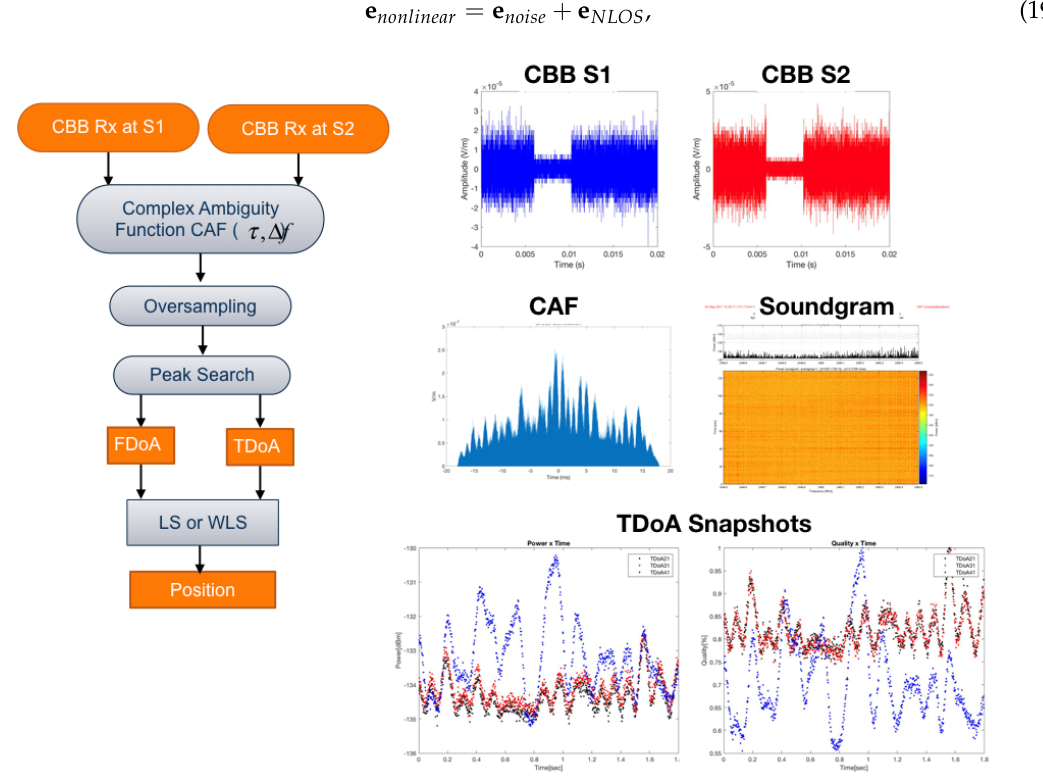
Figure 3. TDOA processing in Sensor 1 and 2.